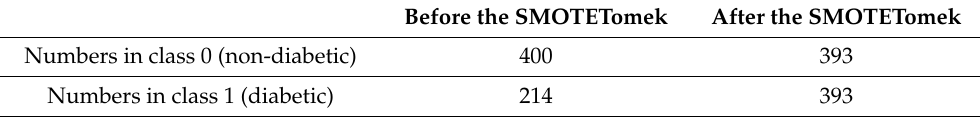
Table 3. Number of classes before and after using the SMOTETomek on the training dataset. Before the SMOTETomek